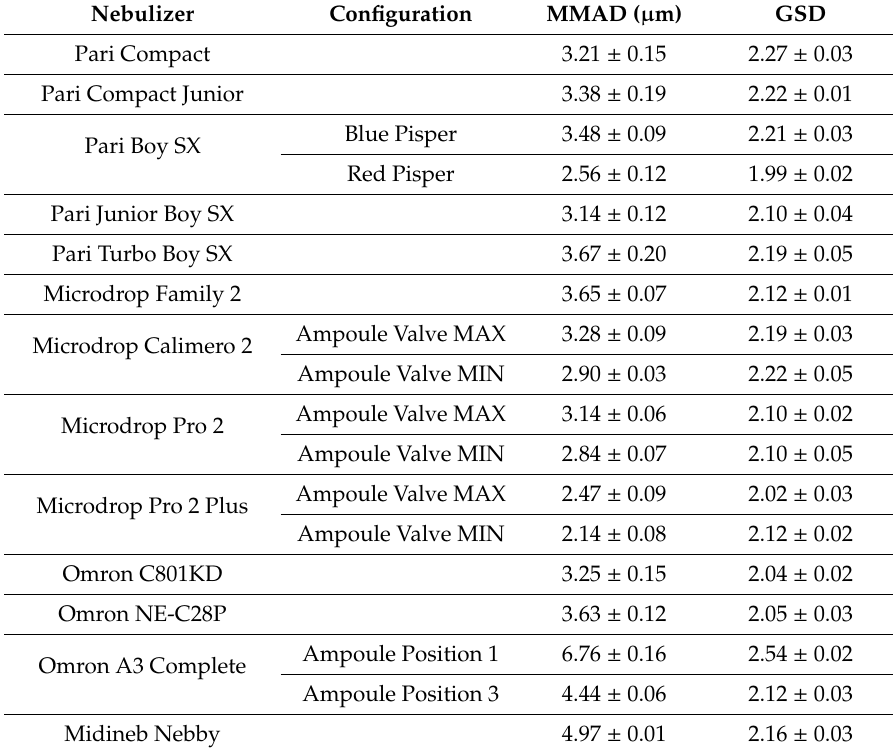
Table 2. MMAD (mass median aerodynamic diameter) and GSD (geometric standard deviation) (mean ± standard deviation, n = 3) resulting from nebulization of NaF solution with the selected